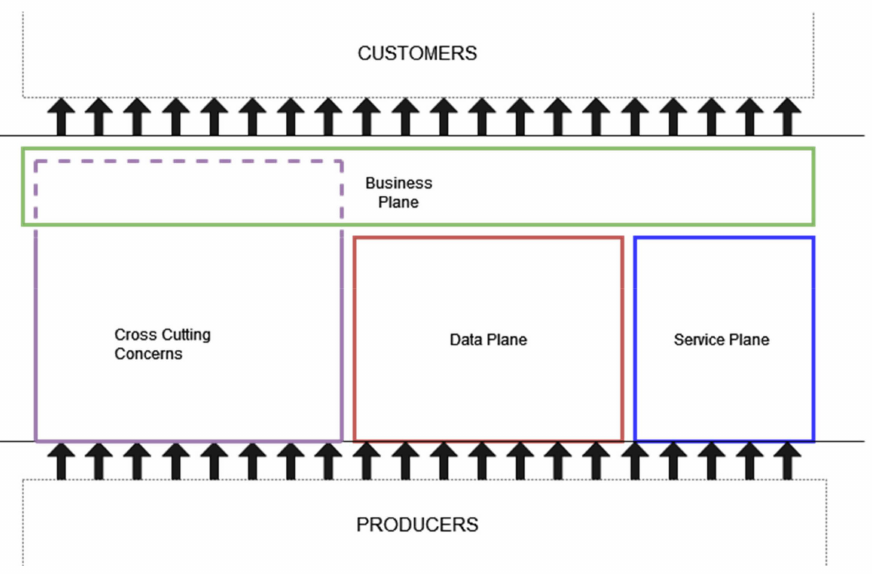
Figure 1. High-level vision of the APERTO5.0 architecture in terms of the layers connecting providers to